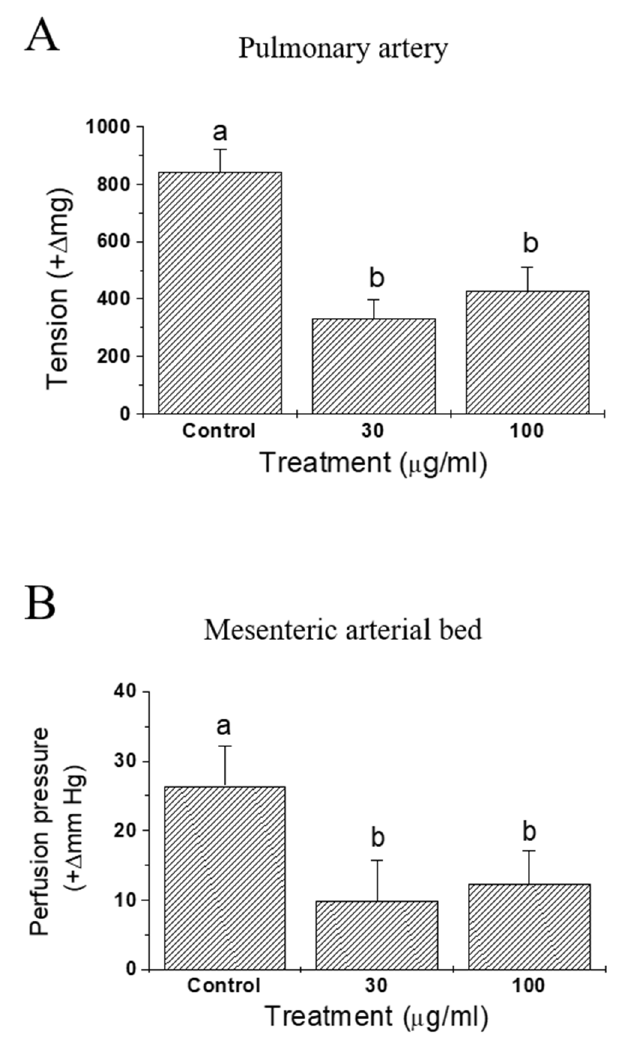
Figure 4. E ff ects of isoquercitrin (IQ) on anaphylactic responses in isolated guinea pig blood vessels. ( A ) Pulmonary artery tension and ( B ) pressure in mesenteric arterial bed were measured in isolated blood vessels from the Hartley guinea pigs ( n = 7 per group). DMSO was used as the control. Di ff erent alphabets on the bars denote significantly di ff erent means at p < 0.05.